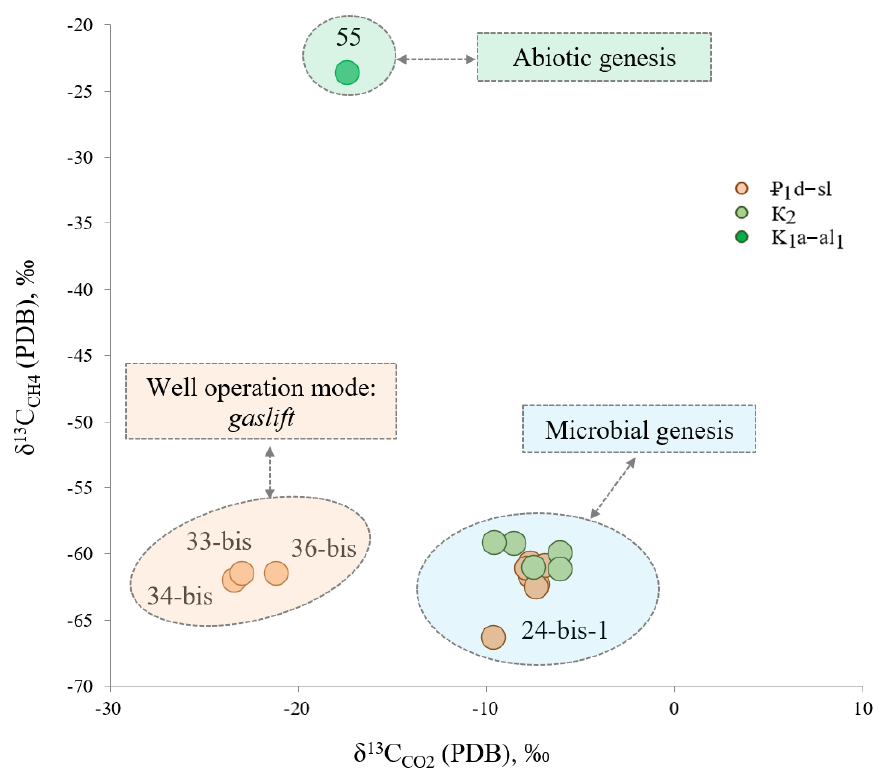
Figure 13. Distribution of δ 13 C PDB in free gases of mineral water of the Essentuki field.